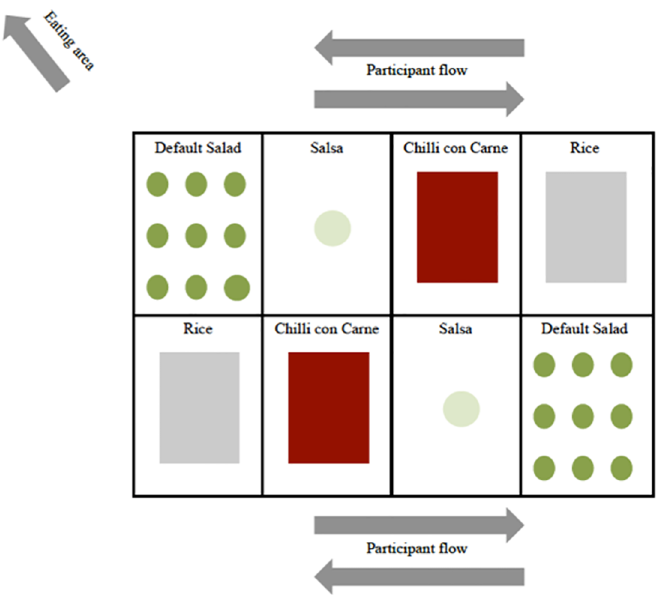
Fig 3. Visual presentation of the experimental setting: Default. The salad was pre-portioned into transparent bowls of 150g of the white salad and 50g of the red salad.